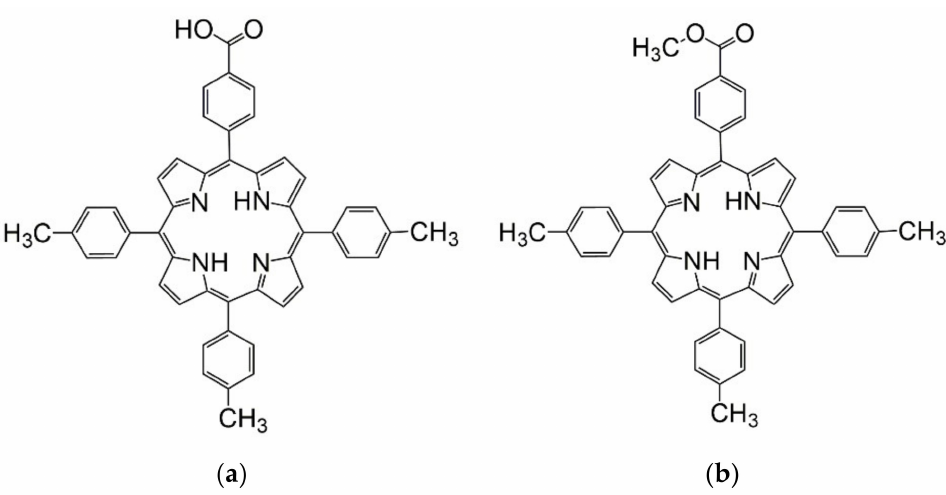
Figure 1. Chemical structures of 5-(4-carboxy-phenyl)-10,15,20-tris (4-methyl-phenyl)-porphyrin ( a ) and 5-(4-methyl-benzoate)-10,15,20-tris (4-methyl-phenyl)-porphyrin ( b